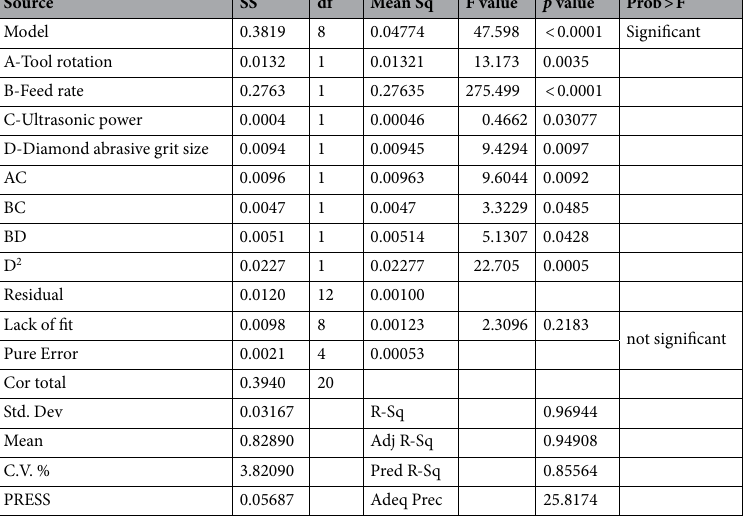
Table 6. ANOVA for response surface of R a .